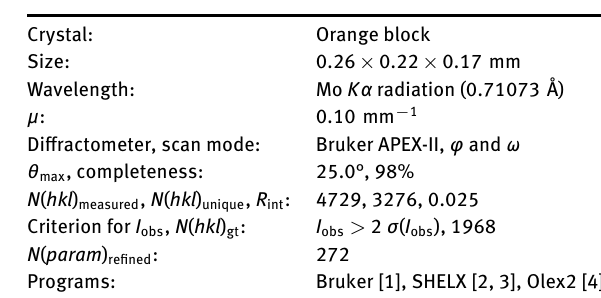
Table 1: Data collection and handling.